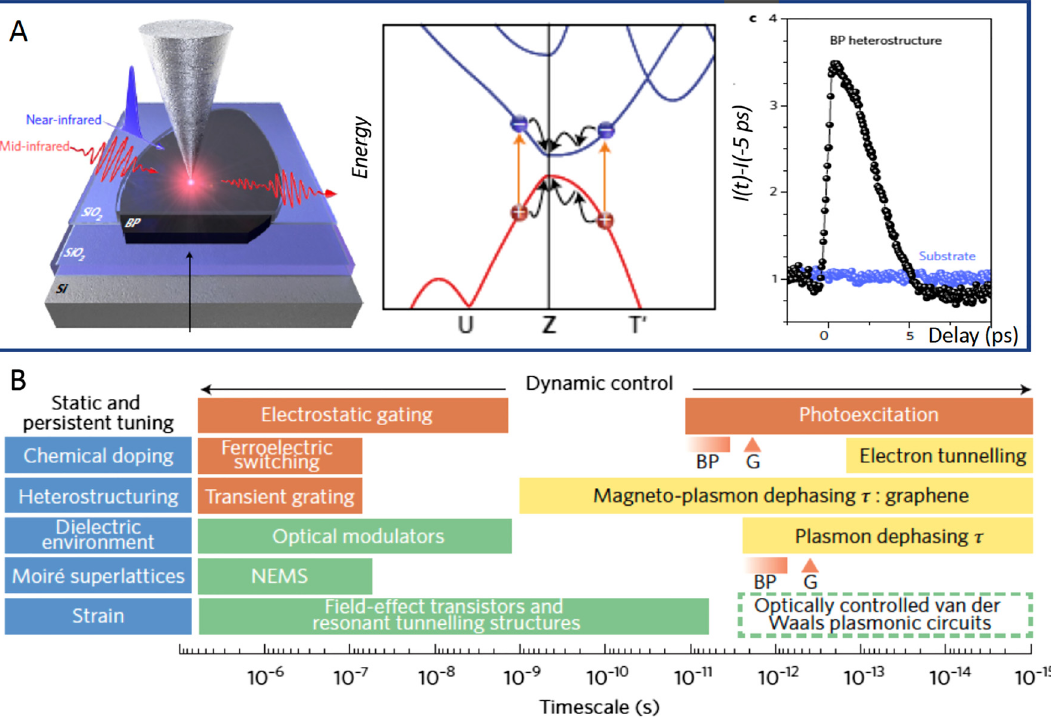
Figure 7: Ultrafast plasmonic effects in van der Waals materials. Panel A: nanoinfrared spectroscopy and imaging of switchable plasmon polaritons in black phosphorous (bP) semiconductor. Left: experimental schematics. Middle: band structure of bP. Orange arrows indicate electron – hole pairs excited by a near-infrared pulse centered at a wavelength of 1560 nm. The curved black arrows indicate carrier cooling toward the band extrema. Right: Ultrafast pump – probe dynamics of the scattered near- fi eld intensity normalized to the signal at the negative delay time (equilibrium). The SiO 2 substrate (blue points) shows no dynamics, whereas the SiO 2 /bP/SiO 2 heterostructure(blackpoints)featuresastrongpump – probesignal.AdaptedfromastudybyEiseleetal.[362].PanelB:methodsfor controllingplasmons invanderWaalsmaterials andthecorrespondingtimescales. Staticandpersistent tuningmethodsaredisplayedintheblue boxes; dynamical control methods are displayed in the orange ones. The yellow boxes show the dephasing times ( τ ) of plasmons and magneto plasmons in van der Waals materials along with characteristic timescales of electron tunneling in these systems. The green boxes represent timescalespertinentforvariousphotonicstechnologies.Theboxwiththedashedgreenoutlineindicatesthedesiredtimescalesforfutureultrafast plasmonic circuits. NEMS, nanoelectromechanical systems; G, graphene. Adapted from a study by Basov et al.